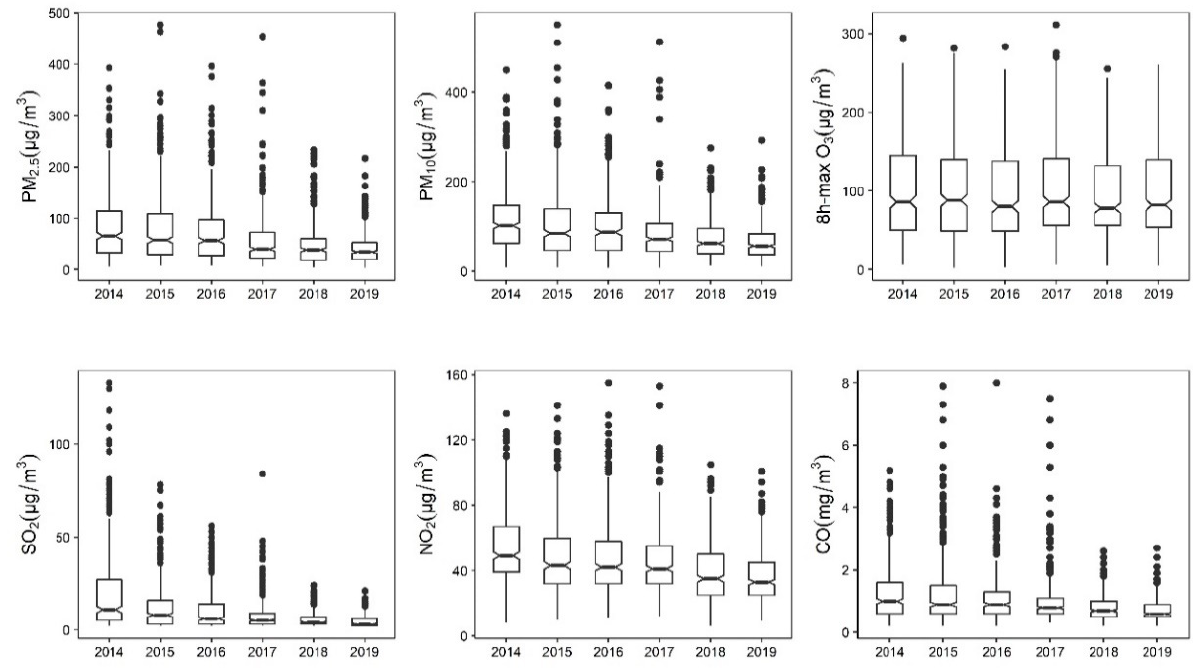
Figure 1. Annual distributions of daily average concentrations of ambient PM 2.5 , PM 10 , 8 h maximum O 3 , SO 2 , NO 2 and CO in Beijing during the study period (2014–2019).